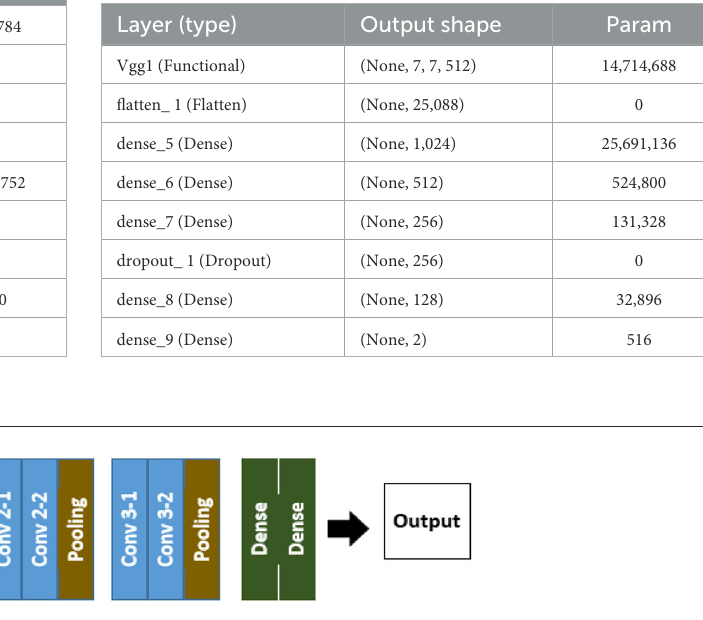
FIGURE4 Network architecture of